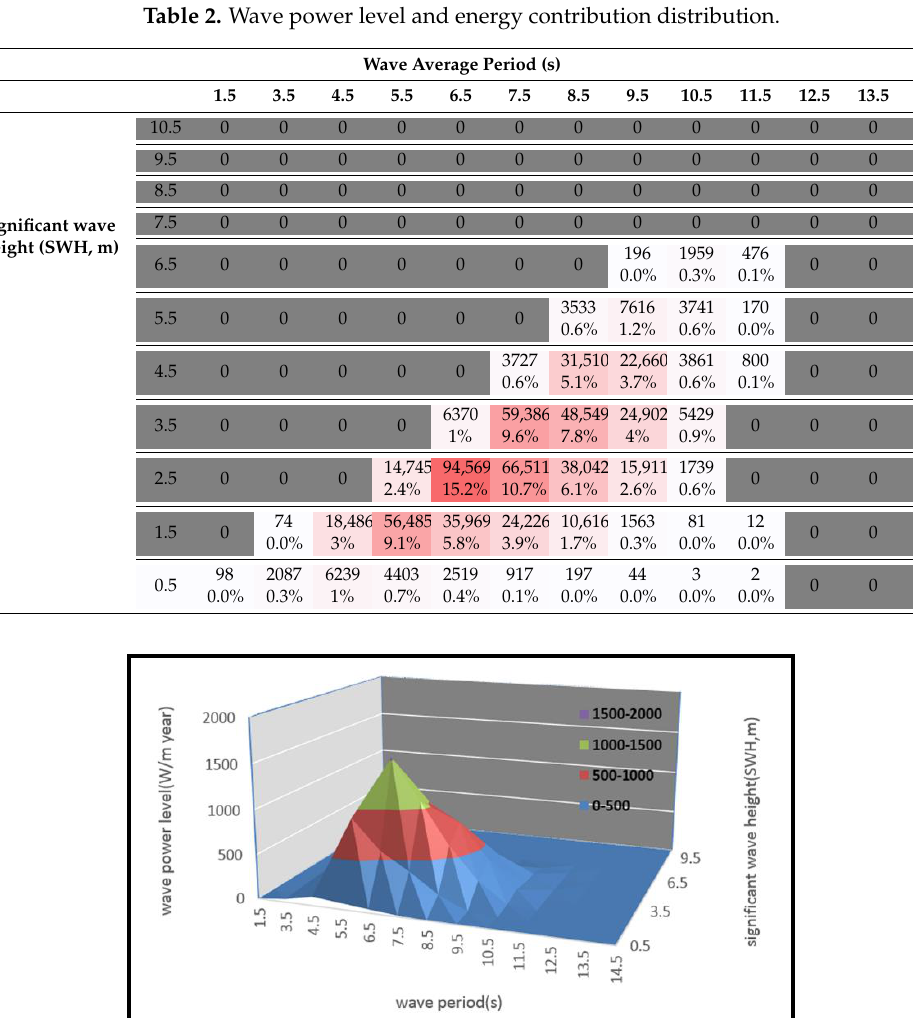
Table 2. Wave power level and energy contribution distribution.